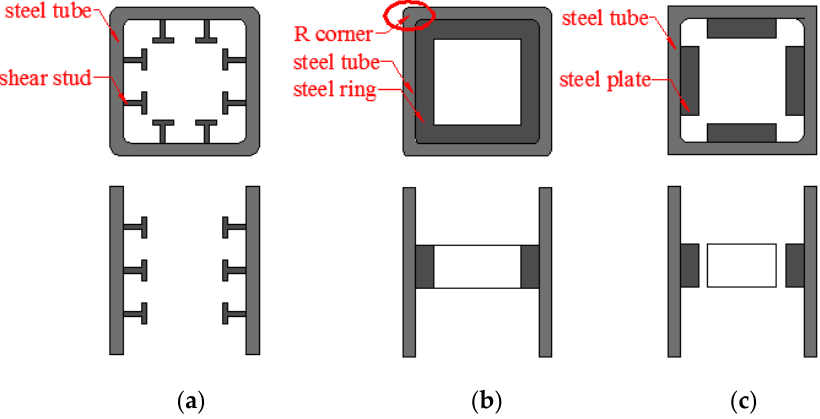
Figure 3. Types of shear connectors. ( a ) Shear studs; ( b ) Steel rings; ( c ) Steel plate.